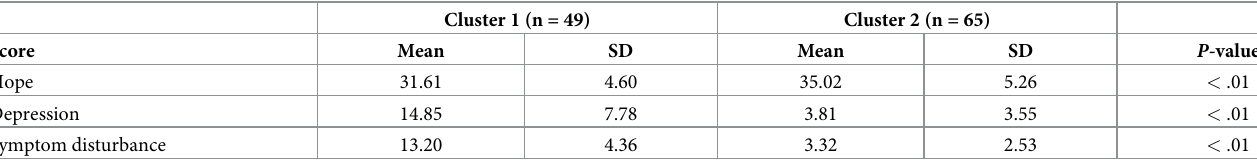
Table 3. Scores for hope, depression and symptom disturbance by cluster analysis.